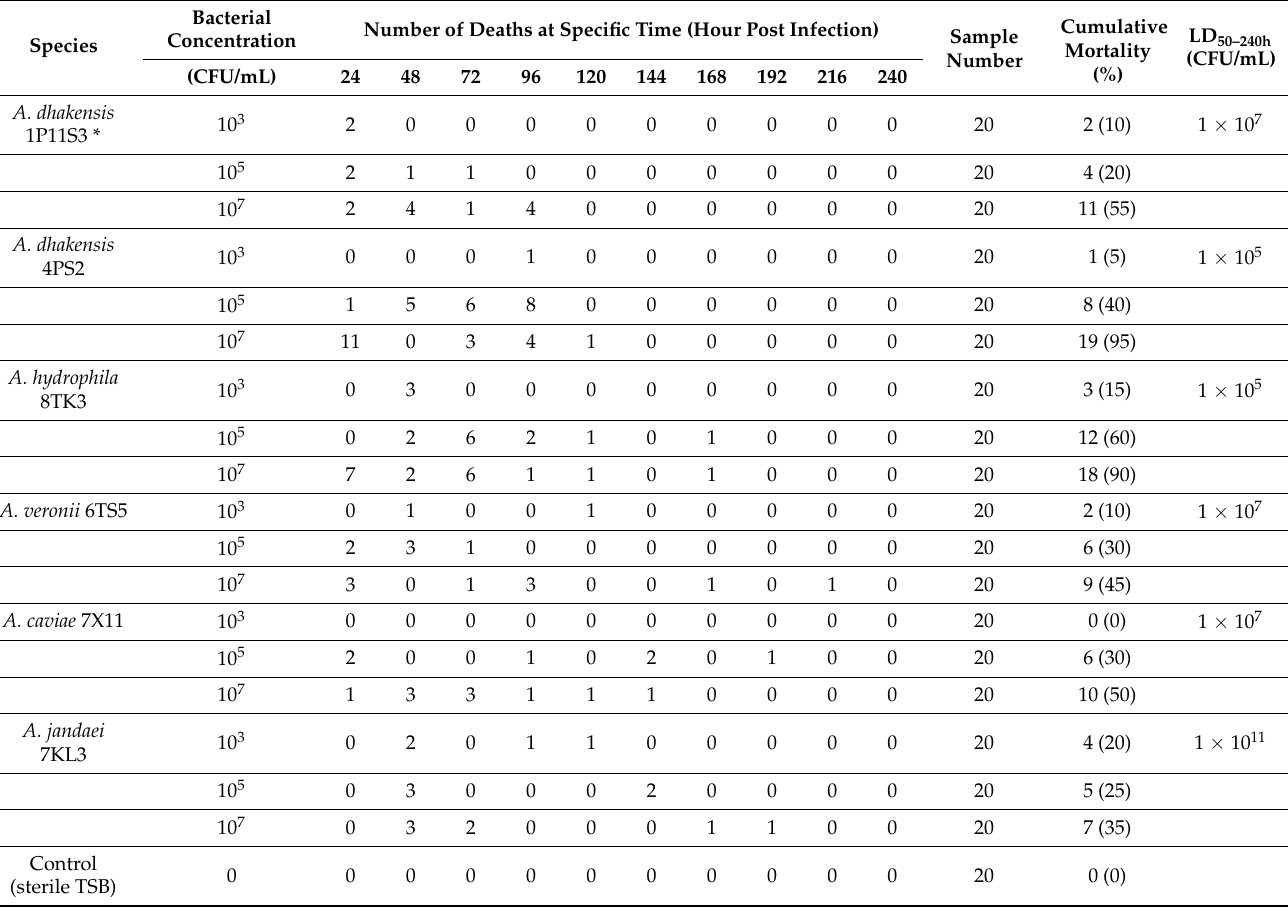
Table 1. The number of mortalities of red hybrid tilapias infected with six strains of Aeromonas spp. Bacterial Number of Deaths at Specific Time (Hour Post Infection) Sample Concentration Species